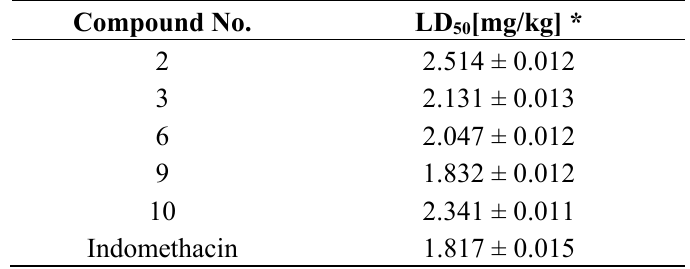
) of some of synthesized 50